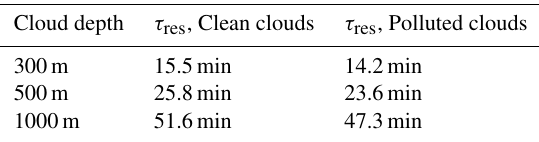
Table A2. Computed cloud residence times for clean and polluted clouds for three cloud